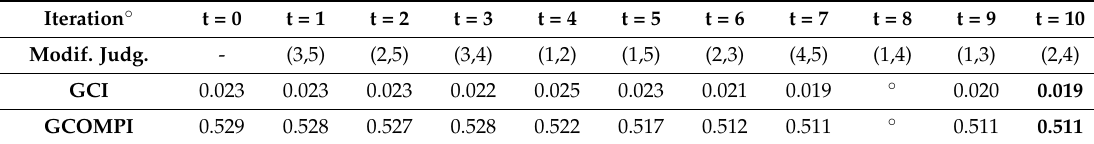
Table 6. Results for the iterative procedure with θ = 0.75 (the best value of the methods is in bold, for each indicator).